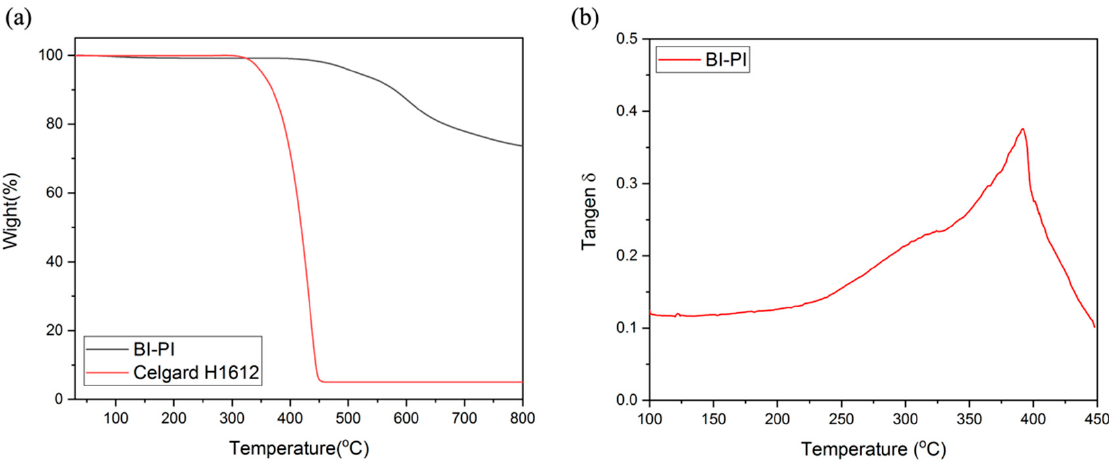
Figure 3. ( a ) TGA thermograms of BI-PI and Celgard H1612 in nitrogen. ( b ) DMA thermogram of BI-PI. of BI-PI.